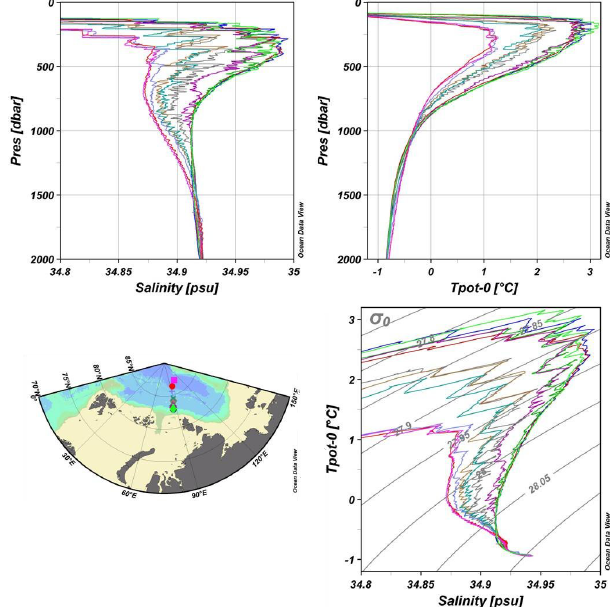
Fig. 12 . Profiles of salinity and potential temperature and θS curves from SPACE section 4 along the Gakkel Ridge showing the regu- lar interleaving layers and the gradual reduction in temperature and salinity from the slope to the basin.